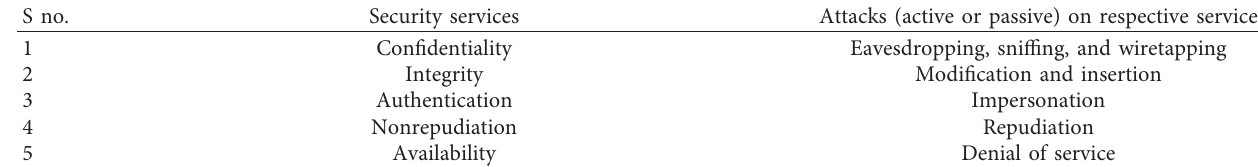
Table 1: Evaluation